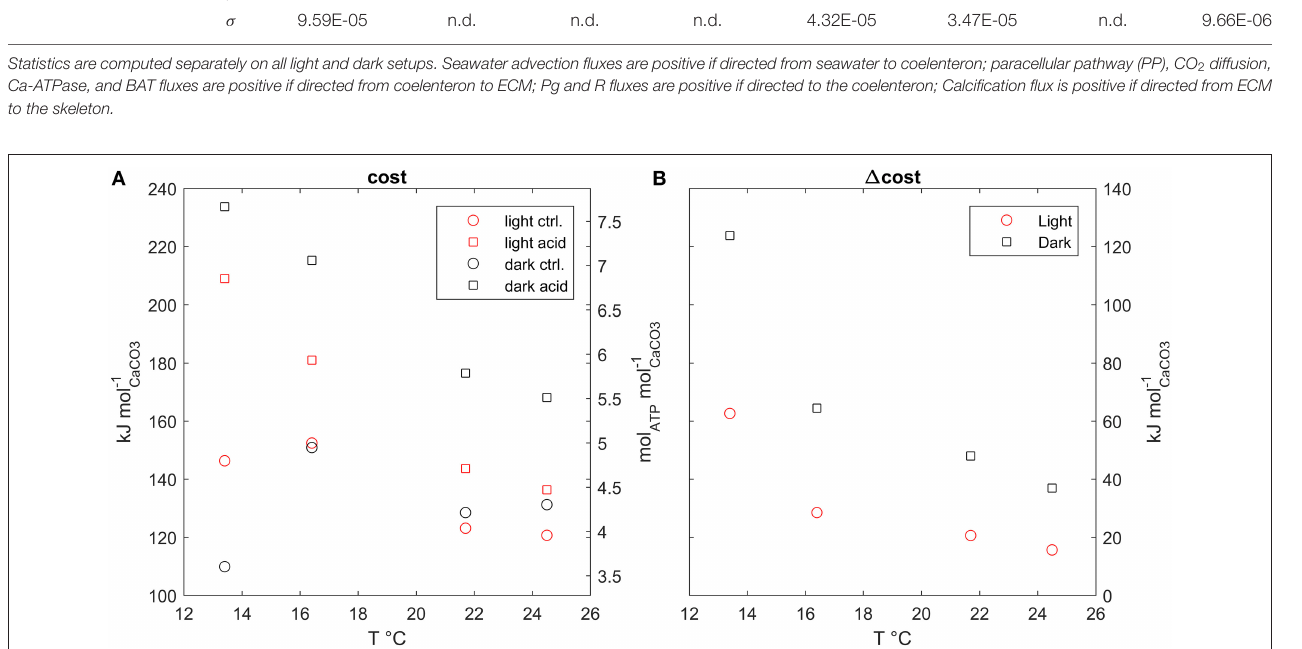
extra costs of calcification due to acidified conditions are larger in the dark than under the